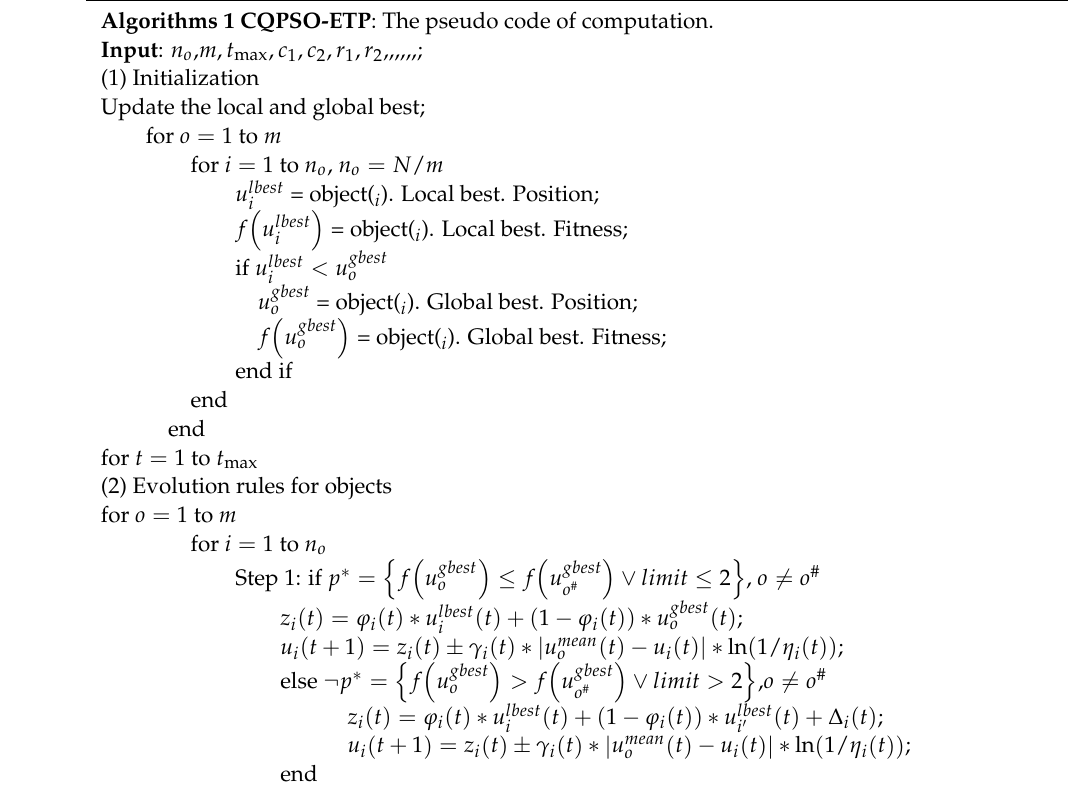
Algorithms 1 CQPSO-ETP : The pseudo code of